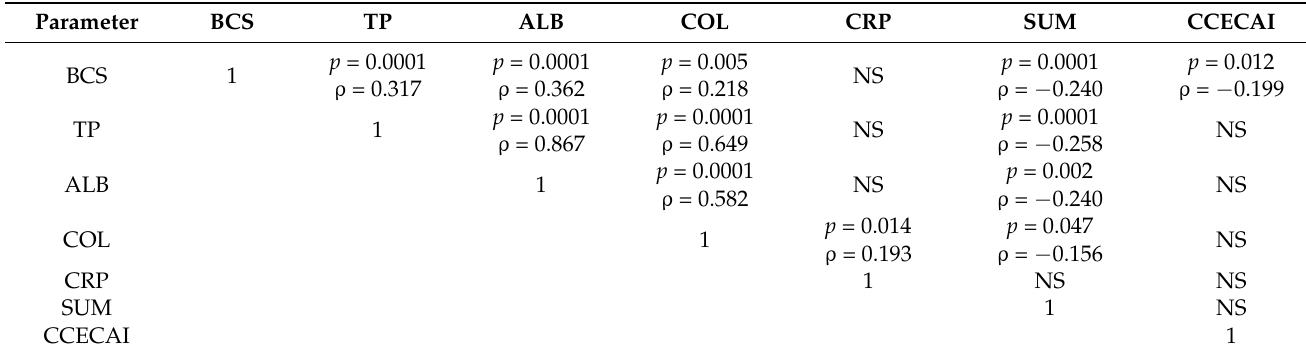
Table 3. Correlations between clinical and haematological variables at admission in 165 dogs with immunosuppressant- responsive and non-responsive